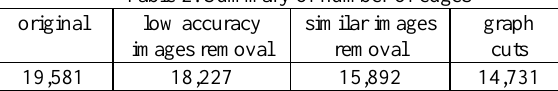
Table 2. Summary of number of